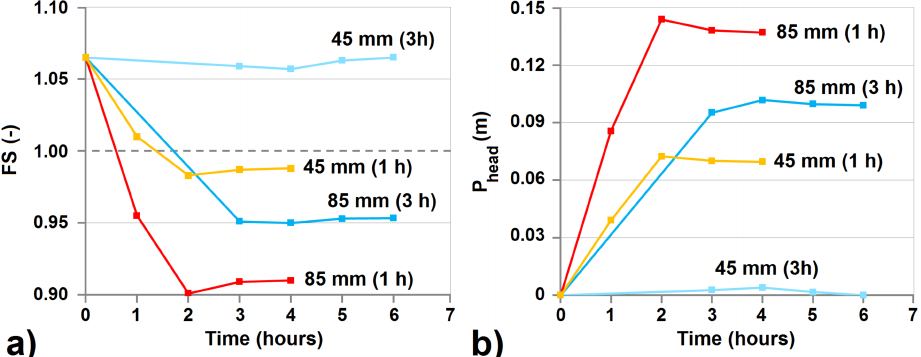
Figure 13. (a) safety factor (SF) vs. time at the selected grid cell of interest for different rainfall scenarios, based on the TRIGRS numerical simulation; (b) Pressure head vs. time at the selected grid cell of interest for different rainfall scenarios, based on the TRIGRS numerical